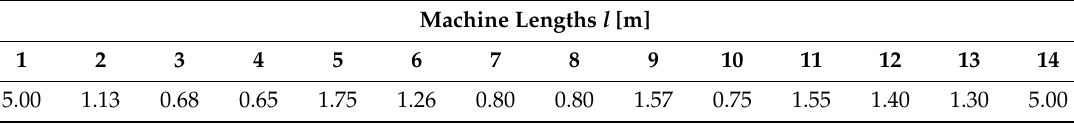
Table 6. Machine lengths l for the analyzed case.